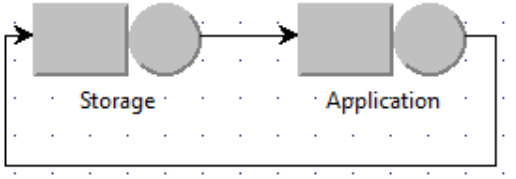
Figure 3. Minimum number of used VMs with asynchronous access.